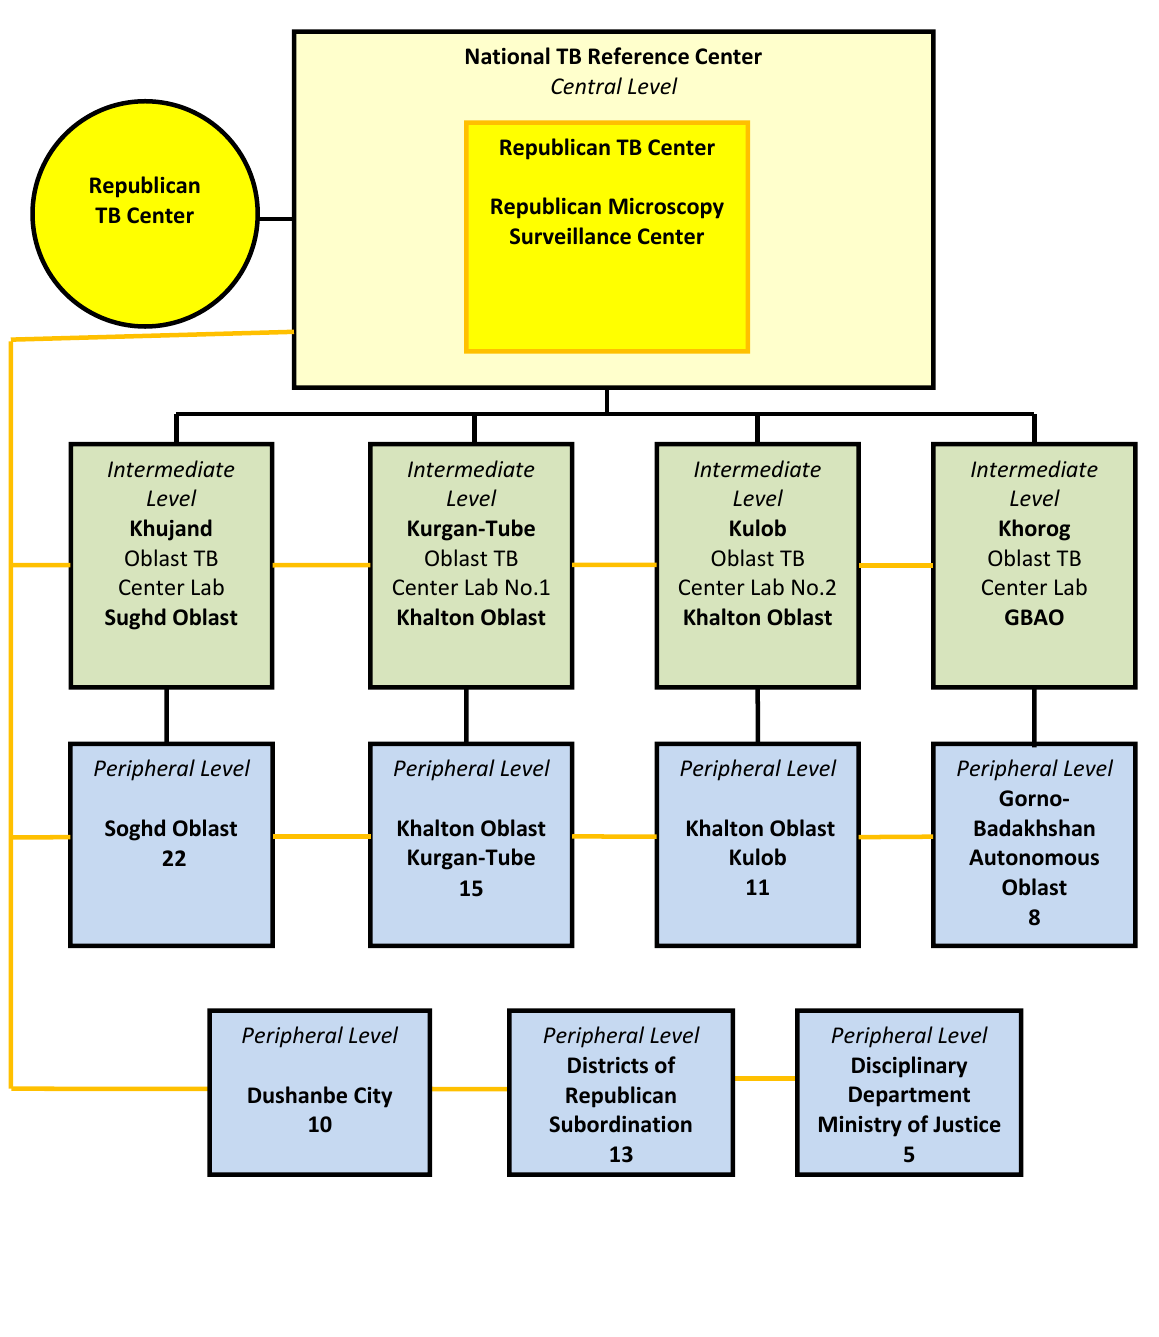
Figure S1: The Structure of Government TB Microscopic Laboratory Network in Tajikistan